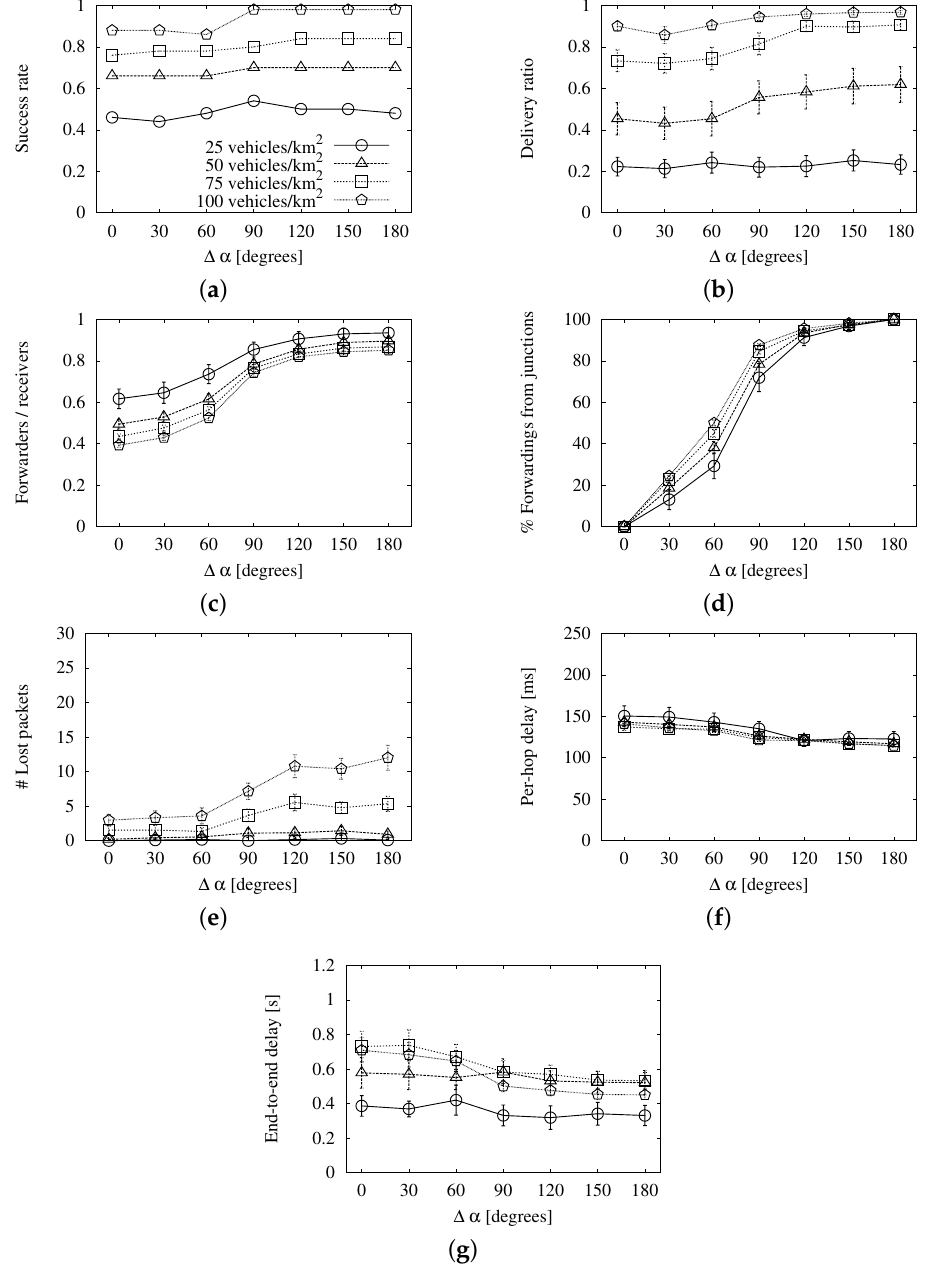
Figure 5. Results of the angle-based scheme with fixed T max and T j , and varying ∆ α in the New York scenario: ( a ) long-reach success rate; ( b ) delivery ratio; ( c ) forwarding ratio; ( d ) portion of relays from junctions; ( e ) number of lost packets; ( f ) average per-hop delay; ( g ) average end-to-end